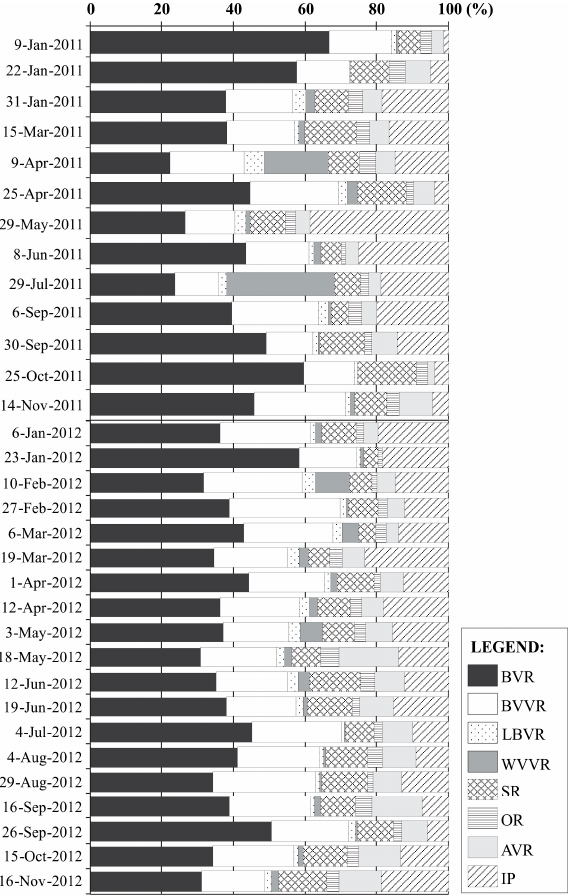
Figure 2. BSE image of volcanic ash: ( A ) BVR; ( B ) BVVR; ( C ) LBVR; ( D ) WVVR; ( E ) SR; ( F ) OR; ( G ) AVR; and ( H ) IP (plagioclase).